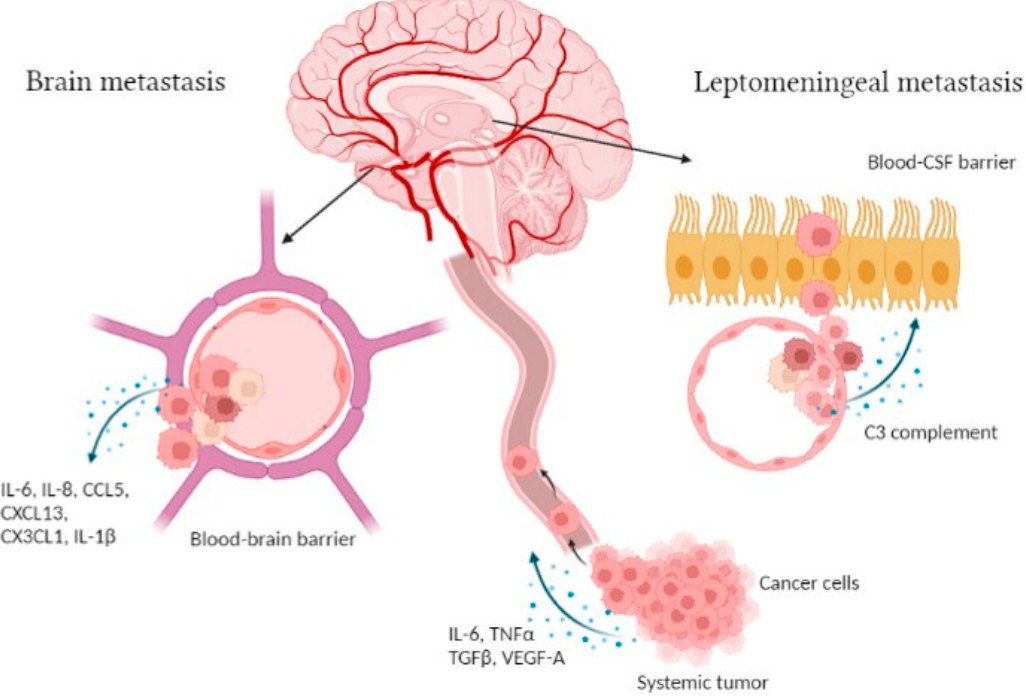
Figure 1. Illustration of the brain and leptomeningeal metastasis development. During the first steps of the CNS metastasis process, cells dissociate from the systemic tumor site and secrete various factors, such as IL-6, TNF α , TGF β and VEGF-A [18]. Those cells travel in the bloodstream to the brain parenchyma where they cross the BBB following cytokine release, i.e., IL-6, IL-8, CCL5, CXCL13, CX3CL1 and IL-1 β [20,22,23]. Regarding leptomeningeal metastasis, cancer cells pass through the B-CSF barrier via C3 complement secretion [32]. Figure created with Biorender.